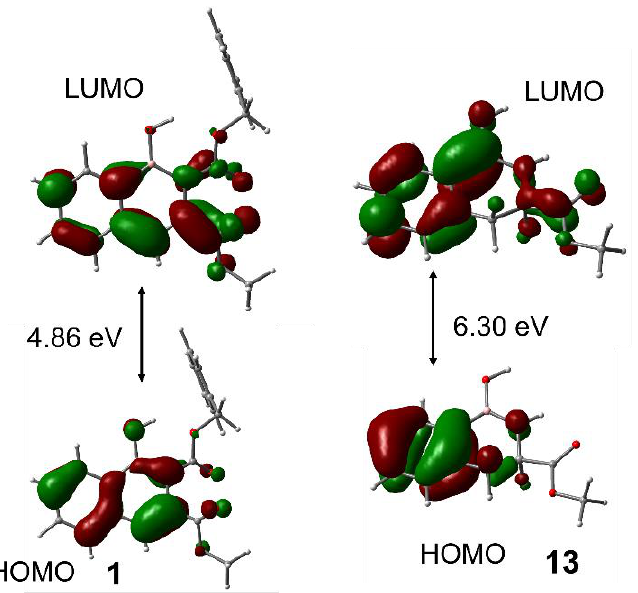
Figure 5. Comparison of the frontier molecular orbitals of compounds 1 and 13 .